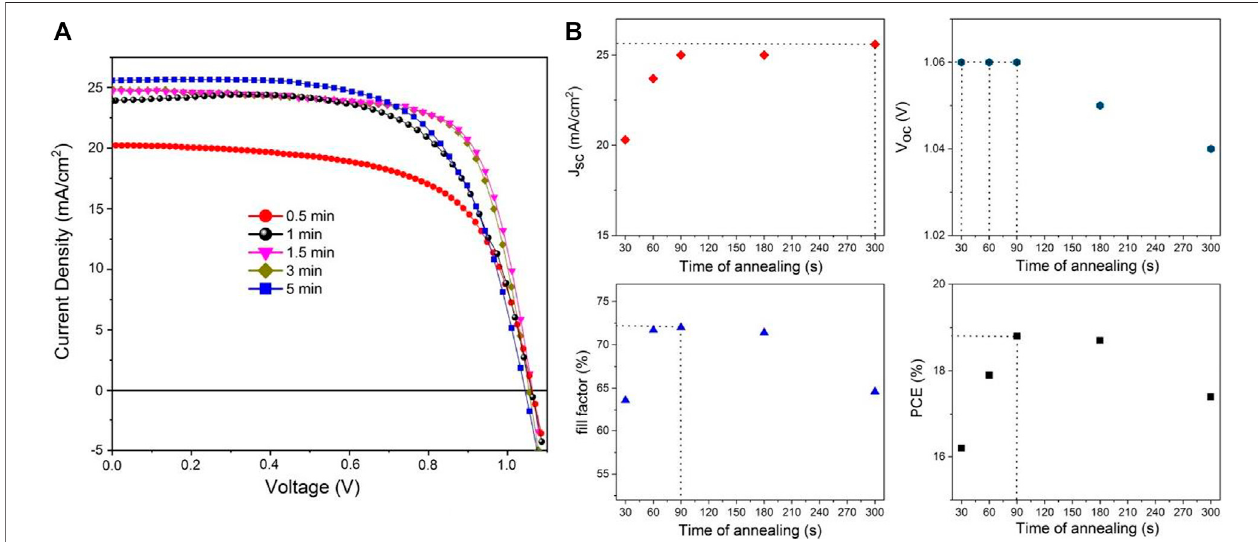
FIGURE 7 | (A) Evolution of the ( J-V ) curve of MAPbI 3 -based devices prepared with a post-annealing of 200 ° C for different annealing time, (B) Evolution of the cell characteristics (V oc , J sc , FF and PCE) as a function of annealing time. (scan rate: 10 mV s − 1 ; area: 0.16 cm 2 ; without any prior light soaking or pre-treatment applied to cell).